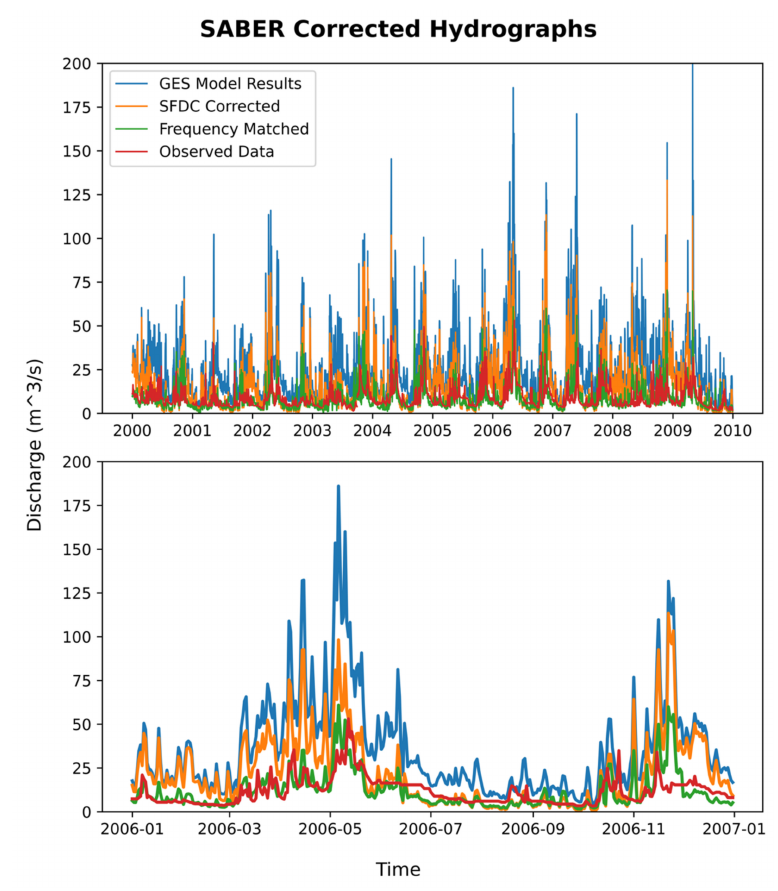
Figure 11. Two hydrograph plots of uncorrected, SFDC corrected, frequency matched, and observed discharge for a 10-year period ( Top Panel ) and a 1-year period ( Bottom Panel